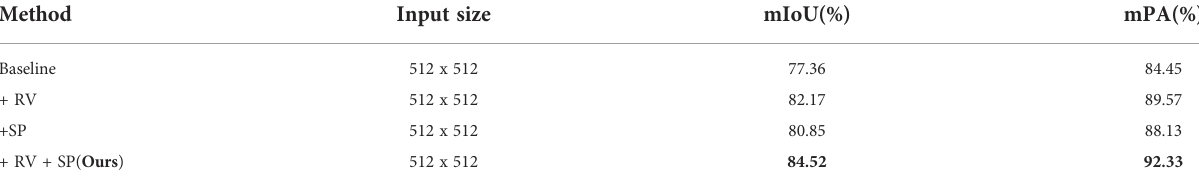
TABLE 8 Ablation